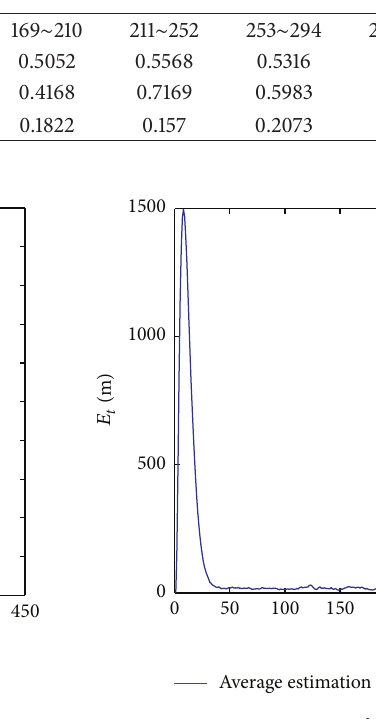
Figure 24: Estimation error of 𝛼 - 𝛽 - 𝛾 filter with 𝑔 𝑟,1 = 𝑔 𝑝,1 = 𝑔 2 = 0.1 .